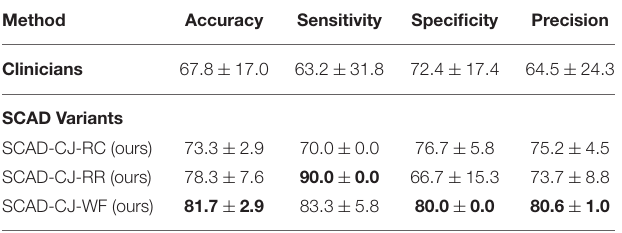
TABLE 5 | Comparison of machine learning models against a group of clinicians (n = 25) in performances (mean and standard deviation of accuracy%, sensitivity%, specificity%, and precision%) on the testing set.